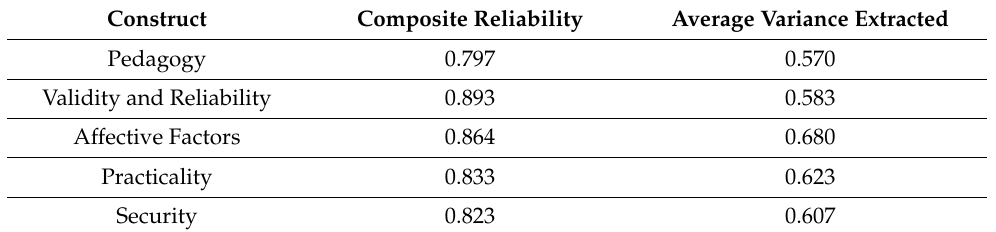
Table 5. Construct Validity